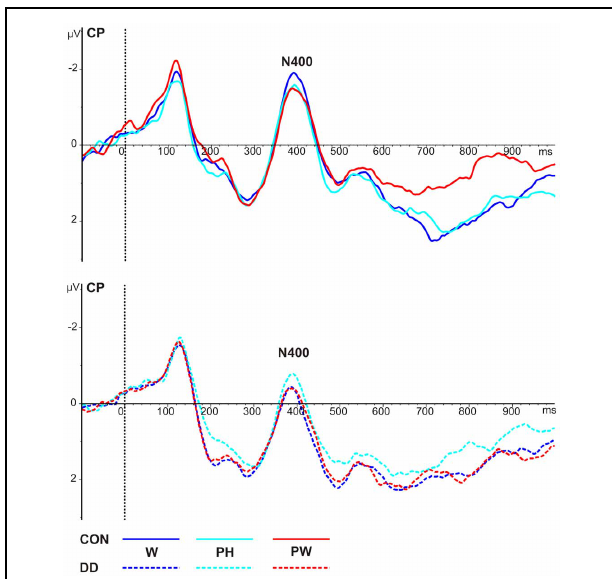
FIGURE 5 | Illustration of the averages across centro-parietal (CP) electrodes included in the ROI of the N400 for control children (CON) and children with DD (DD). W, words; PH, pseudohomophones; PW, pseudowords. Negativity is depicted upwards.